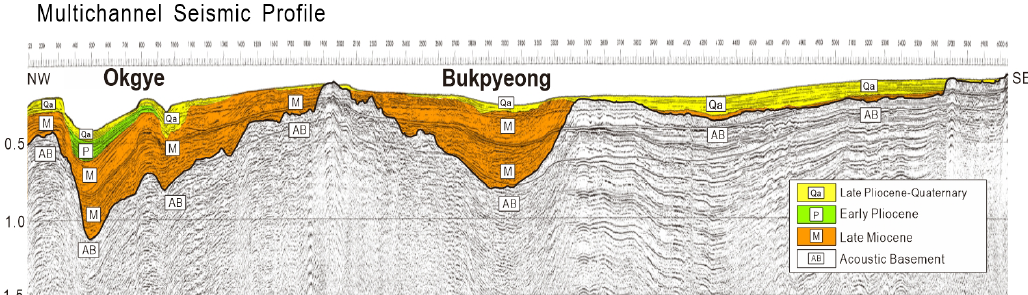
Figure 13. Seismic section obtained parallel to the coastline and its stratigraphic interpretation (modified after Kwon, 2005; Ryang et al., 2007, 2014). For the location of the seismic track line, see Fig. 12.